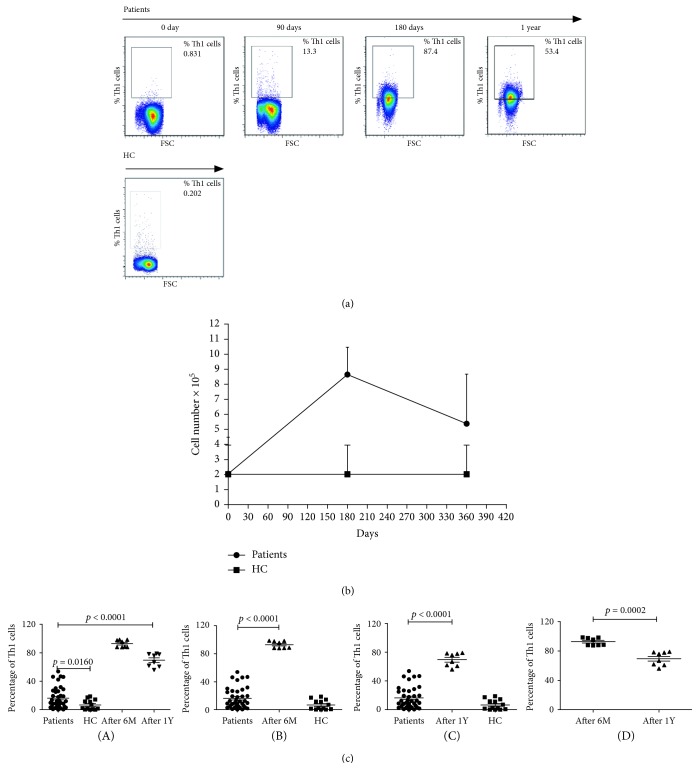
The percentage analysis of serum Th1 cells in different stages at 0, 6, and 12 months. (a) PBMCs were collected in the peripheral blood of new patients and follow-up subjects. The cells were fixed and permeabilized, followed by staining with PerCP-Cy™5.5 mouse anti-human CD3, APC-HT mouse anti-human CD4, and intracellular staining with BV421 mouse anti-human IFN-γ. Next, the frequency of CD3+CD4+IFN-γ+ T cells (Th1) was calculated with pictures showing IFN-γ in different stages. (b) Dynamic changes in Th1 cell numbers at 0, 6, and 12 months. (c) Percentage of Th1 cells in different groups. (A) Data analysis of the percentages of Th1 cells in different groups. The data are shown as the mean values of individual participants from two separate experiments. The horizontal lines indicate the median values of the different groups. A statistically significant difference was found between the patients and HC groups (p < 0.05). (B) Statistically significant differences could be observed in the percentages of Th1 cells between 0 and 6 months later in these two groups (p < 0.05). (C) Statistically significant difference could be observed on the percentages of Th1 cells between 0 and 12 months later in the two groups (p < 0.05). (D) A statistically significant difference was observed in the percentages of Th1 between 6 months and 12 months in the two groups (p < 0.05). Abbreviations: Th1: T-helper type 1; IFN-γ: gamma-interferon; HC: healthy controls.